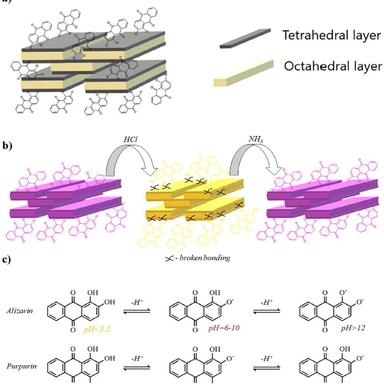
Illustration of the (a) formation mechanism; (b) pH responsive behavior of hybrid pigments based on natural anthraquinone dyes and mineral supports; (c) structures of the studied dyes at different pH.